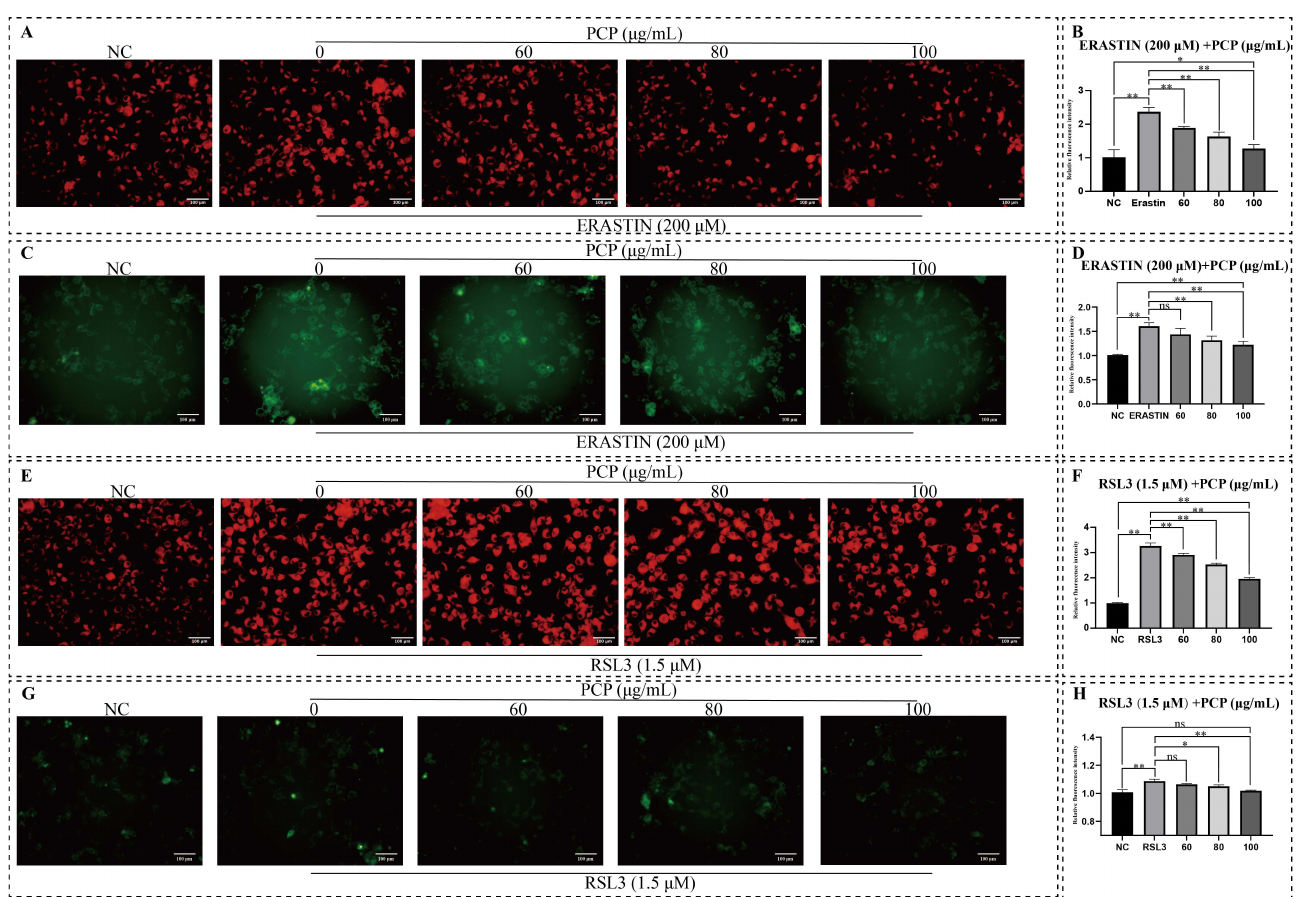
Figure 10. PCP scavenged ERASTIN/RSL3-induced intracellular Fe 2+ in the microglia. The cells were treated using ERASTIN (200 µ mol) or RSL3 (1.5 µ mol) and PCP at different concentrations